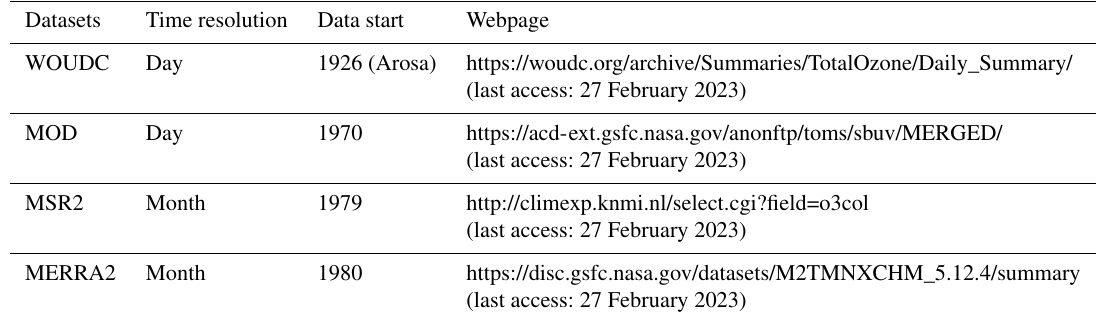
Table 2. Source of total column ozone datasets.